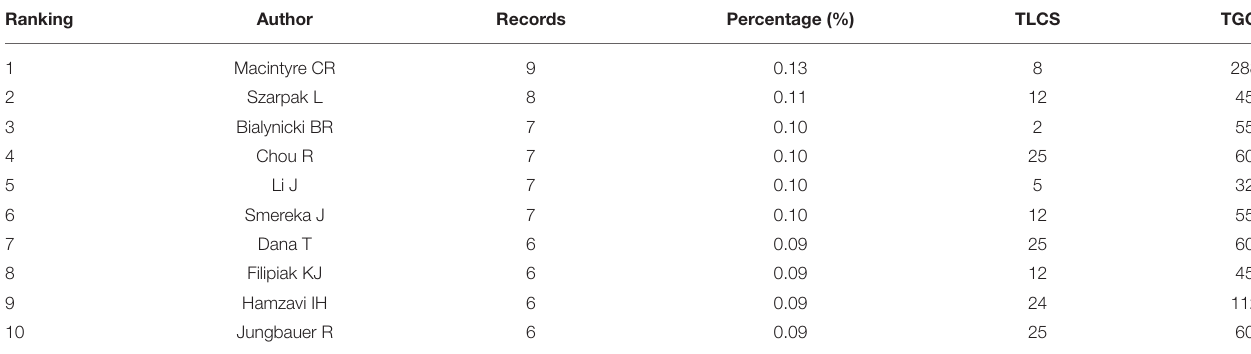
TABLE 2 | Top-10 most prolific authors in COVID-19 and PPE.